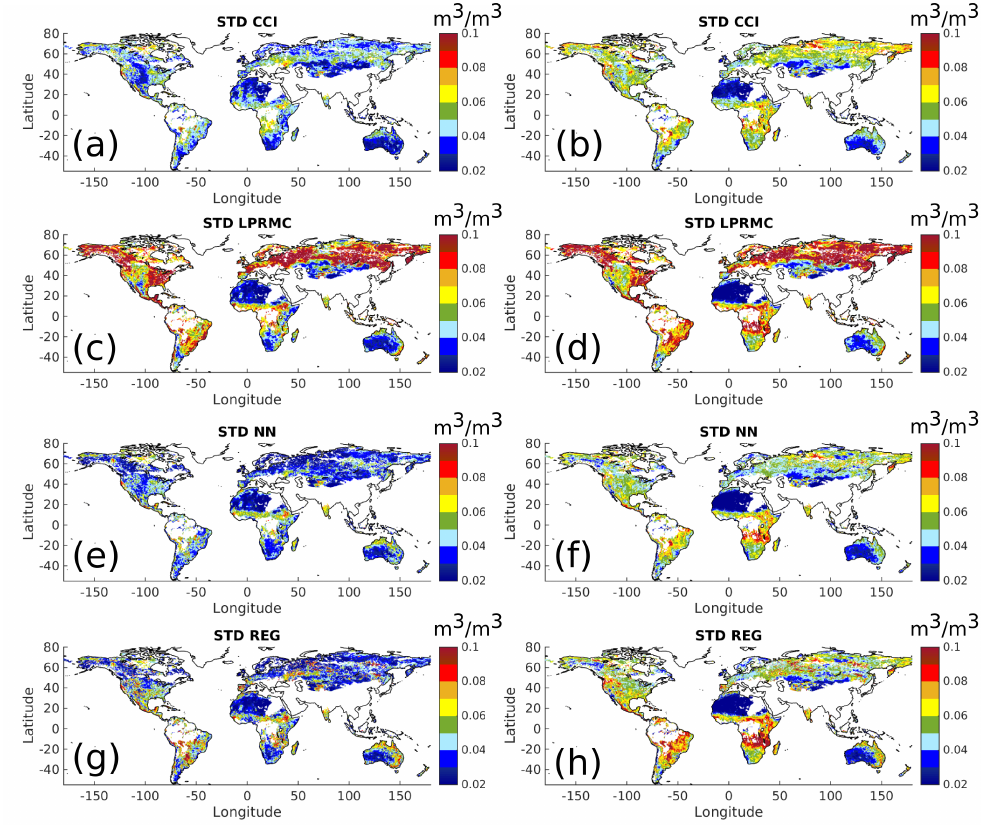
Figure 10. Standard deviation of the difference of remote sensing products with respect to MERRA-Land (left panels) and ERA-Land (right panels). The remote sensing products evaluated are, from top to bottom: ESA CCI ( a , b ); AMSR-E LPRM C-Band ( c , d ); AMSR-E NN ( e , f ); and AMSR-E Reg ( g , h